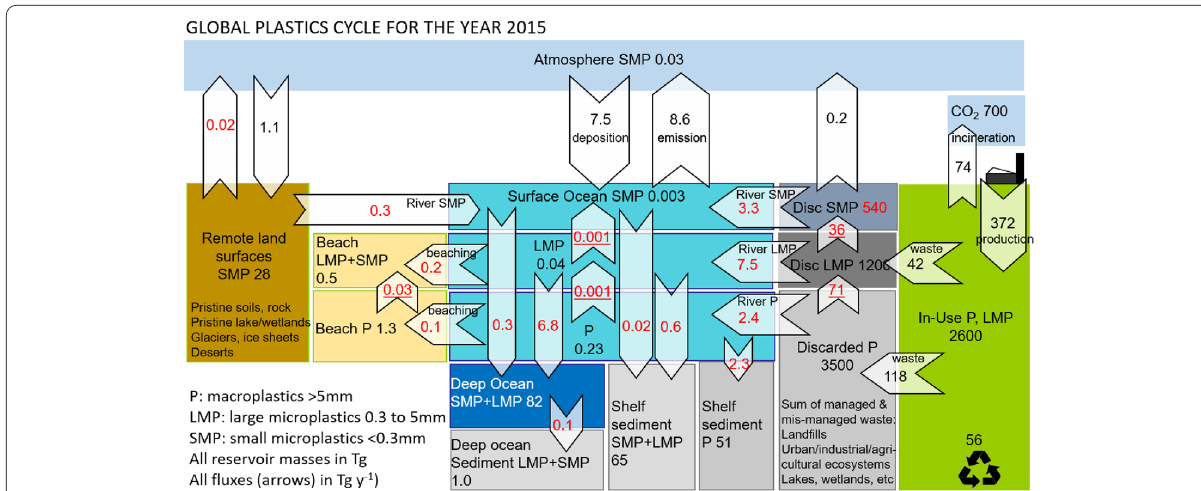
Fig. 1 Global plastics budget and cycle for the year 2015 based on best-available observations and model estimates. Reservoir sizes are shown in teragrams (Tg), and fluxes in Tg y − 1 (arrows). Three plastics size classes are considered: macroplastics > 5 mm (P), microplastics from 0.3 to 5 mm (LMP), and small microplastics < 0.3 mm (SMP) that can become airborne. The discarded (Disc) plastic pools represent the terrestrial technosphere, where managed and mismanaged waste has accumulated in urban-industrial areas, landfills, agricultural soils impacted by mulching or waste disposal, wetlands, lakes and other ecosystems. The remote terrestrial reservoir lies outside the technosphere and is only impacted by airborne SMP deposition, re-emission and runoff. Numbers in black are based on observations, and numbers in red on the box model simulation. Underlined red fluxes indicate P and LMP degradation at a rate of 3% per year. Uncertainties are provided in Table 4. Note that the 2015 global budget is not at steady-state and fluxes and pool sizes continue to gradually increase today and in the